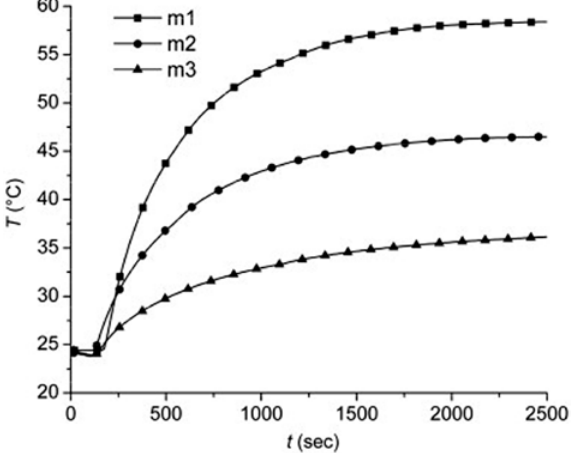
Figure 15: Time dependence of the self-heating temperature on the magnetic field at 104 kHz and the different intensity of the magnetic field for Cu Ni . 1-H = 3830 A/m, 2-H = 3130 A/m, and 3-H = 2408 27.5 72.5 A/m, respectively. Reproduced with permission from Elsevier: Journal of Magnetism and Magnetic Materials